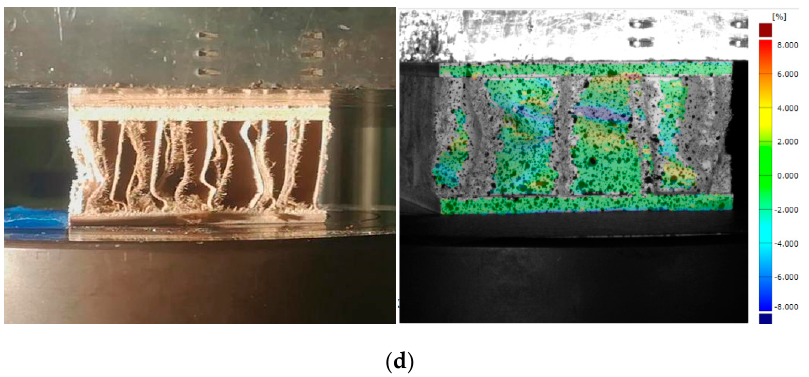
Figure 5. Photographs and digital image of the sandwich structure with a Taiji honeycomb core under compression: ( a ) unloaded; ( b ) buckling of the inclined cell wall; ( c ) buckling of the whole cell wall; ( d ) the plateau stage. The red box on the left of pictures (b) and (c) expresses the deformed process of the cell wall in the honeycomb core. The colored scale on the right of the pictures is the strain distribution along the cross section of the composite.